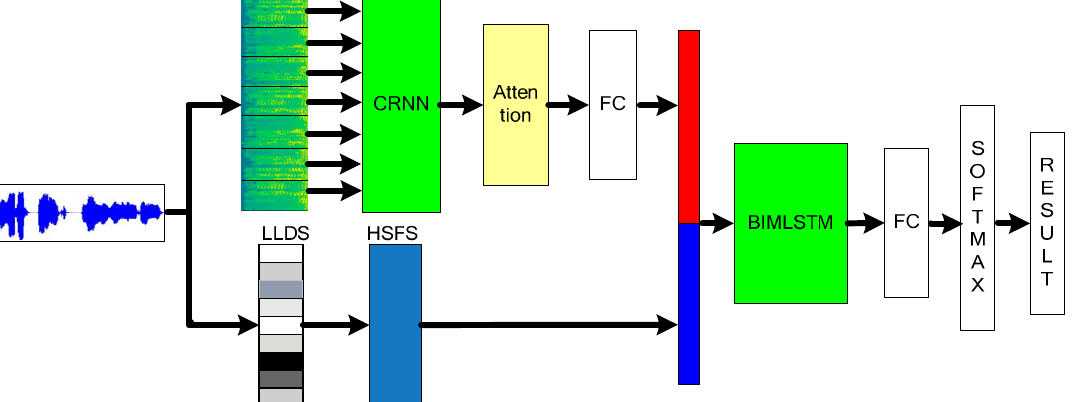
Figure 4. Joint model of high-level statistics functions (HSFs) and CRNN.